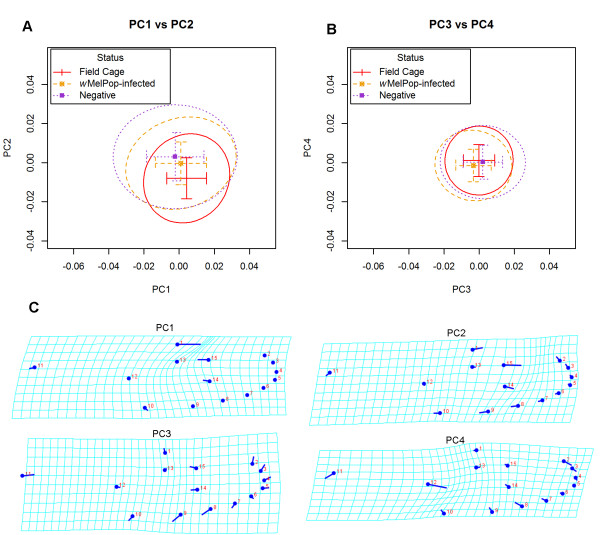
Shape variation in field uninfected, infected field cage and infected field released A. aegypti. Principal components showing the variation in shape for which PC1 explained the greatest variation followed by PC2, PC3, PC4 and so on. (A) PC1 vs. PC2 and (B) PC3 vs. PC4. Means and standard deviations of each group and ellipse outlining 90% of data, showing the high degree of overlap in variation for all groups within the double sticky trap (DST) and field cage data. Both wMelPop-CLA-infected and uninfected mosquitoes were caught in DSTs. (C) Shape variation in PC1, PC2, PC3 and PC4. The procedure over-exaggerates the variation, thus the shape variations were scaled down 10 times.